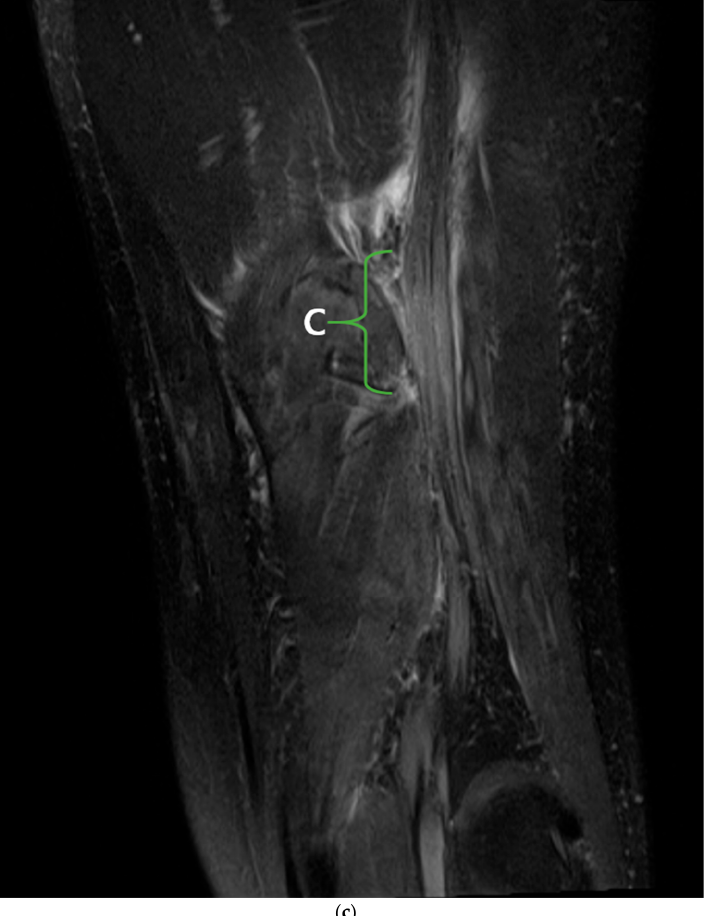
Figure 3. The T1-weighted magnetic resonance (MR) image ( a ) shows ischemic changes in the thigh posterior muscles, as in the previous CT scan. The sciatic nerve is severely swollen compared to the contralateral side, and the T2-weighted signal intensity ( b ) is increased (blue arrow). T1-weighted sagittal imaging ( c ) shows the length of the swollen sciatic nerve (green bracket).